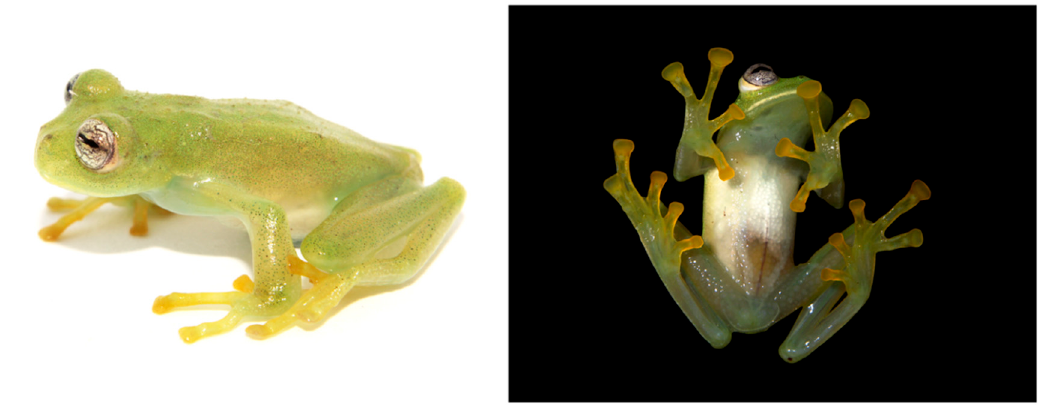
Figure 137. Nymphargus cariticommatus in life from Ecuador, Zamora Chinchipe province, Reserva Tapichalaca, 2200 m. Photos by Mario Yánez (left) and Marco Reyes (right)